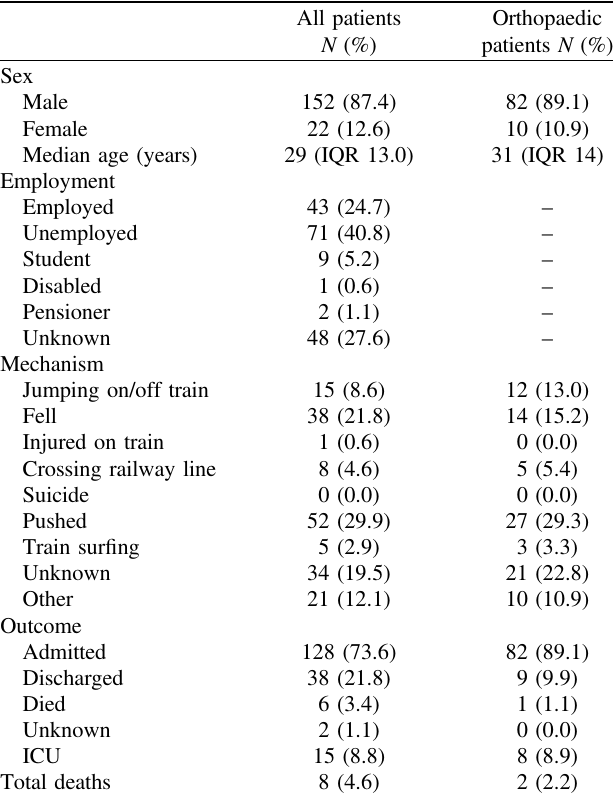
Table 3. Comparison of all patients versus orthopaedic patient demographics.